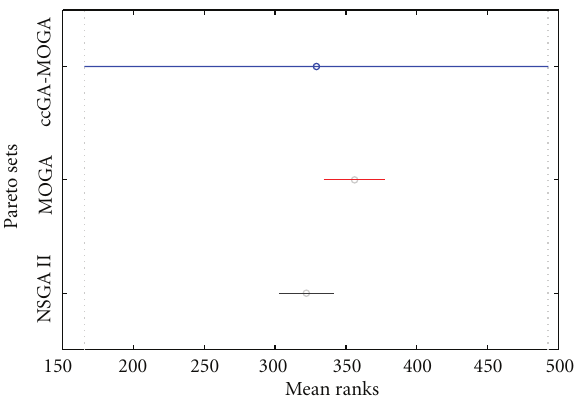
Figure 11: Wilcoxonrank sum test for the rotation lengths from the ccGA-MOGA, MOGA and NSGA II Pareto